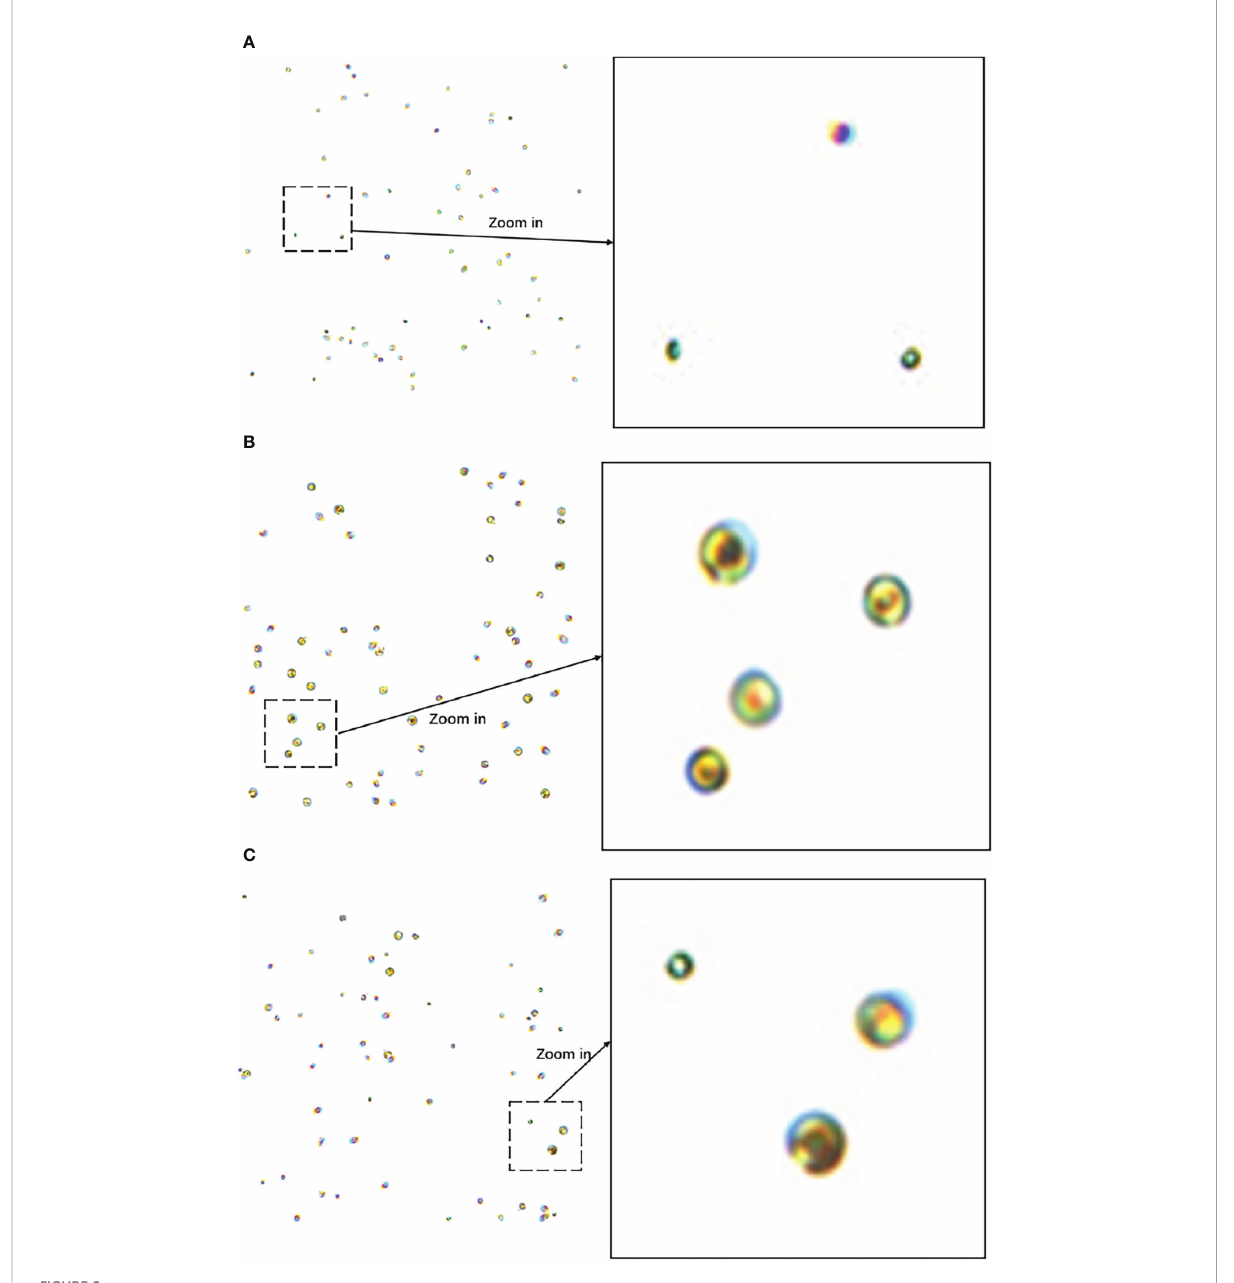
FIGURE 2 (A) Image of Chlorella sp . (B) Isochrysis sp . image (C) Mixed image of Chlorella sp. and Isochrysis sp . Example images of the algae